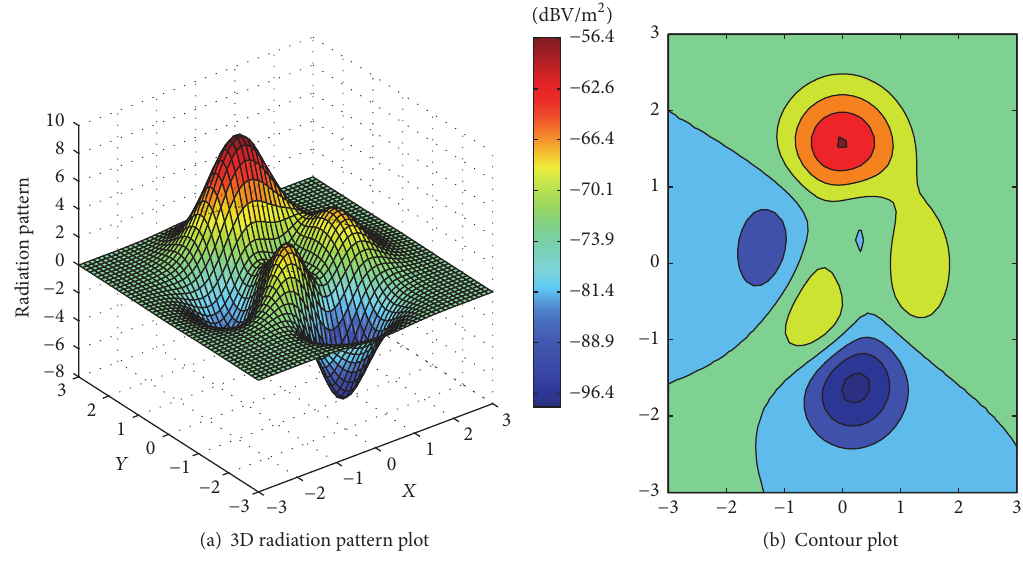
Figure 6: Optimized radiation pattern at centre frequency 2.45 Ghz.